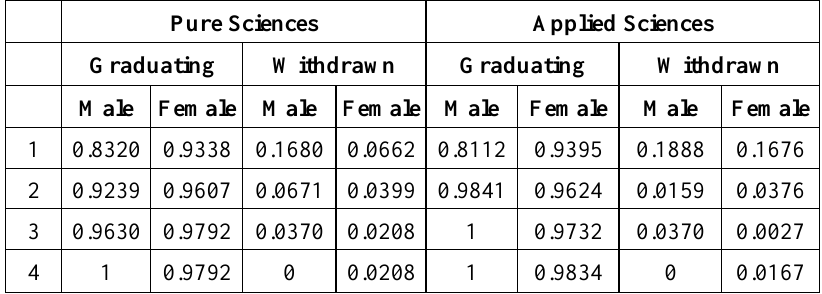
Table 12. Probability of reaching the graduating and withdrawn states by programs and